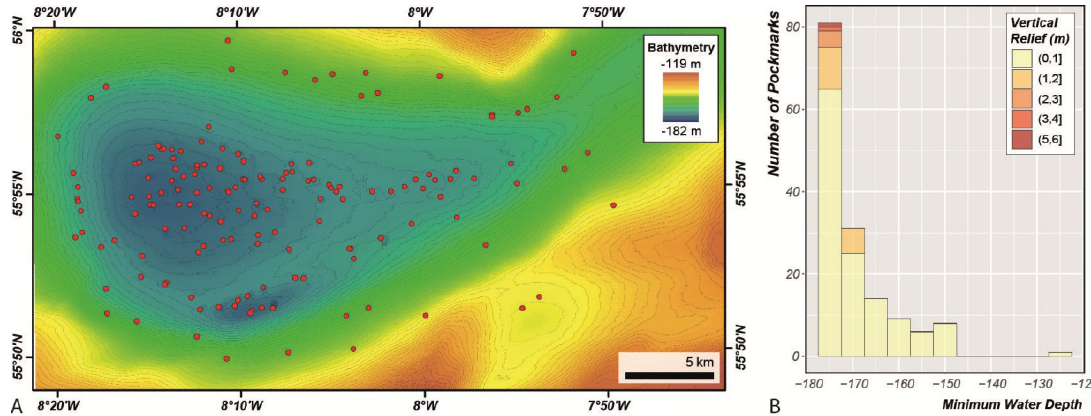
Figure 16. ( A ) Location map of the 150 pockmarks mapped with the BGS Seabed Mapping Toolbox (red dots); ( B ) Vertical Relief as a function of Area for the pockmarks mapped in the Malin Basin.